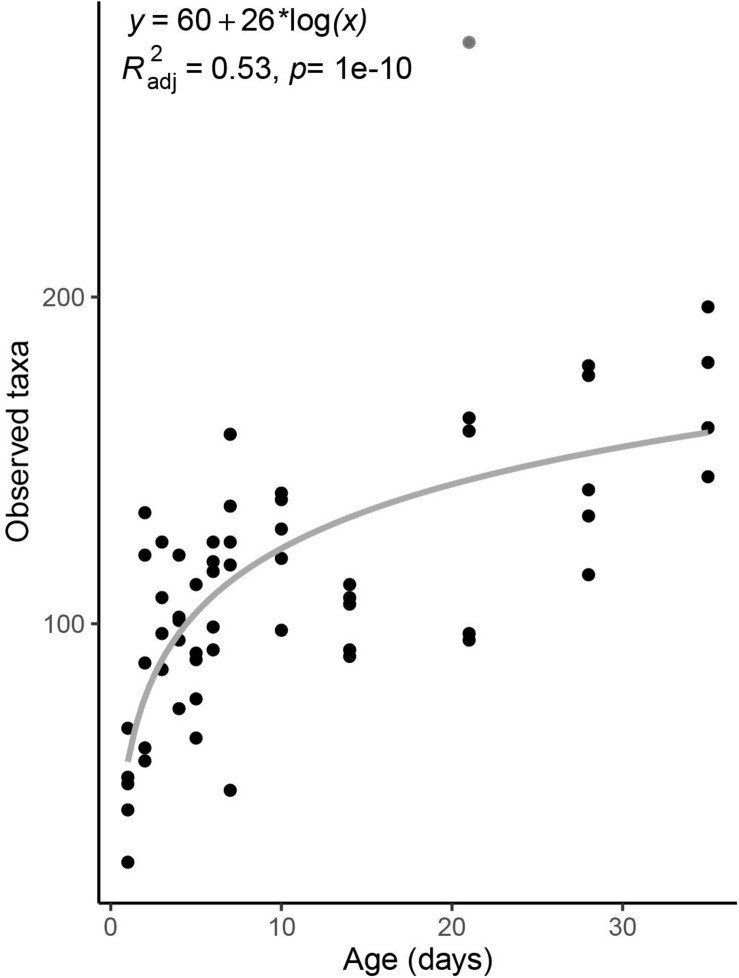
Taxonomic richness in the fecal microbiomes of pigs across age. Taxonomic richness is calculated as the total number of observed ASVs per sample. Gray line is a linear regression line. The derived formula, R2 and significance value are displayed above. One outlier from day 21 was excluded from the regression, and is shown in gray.